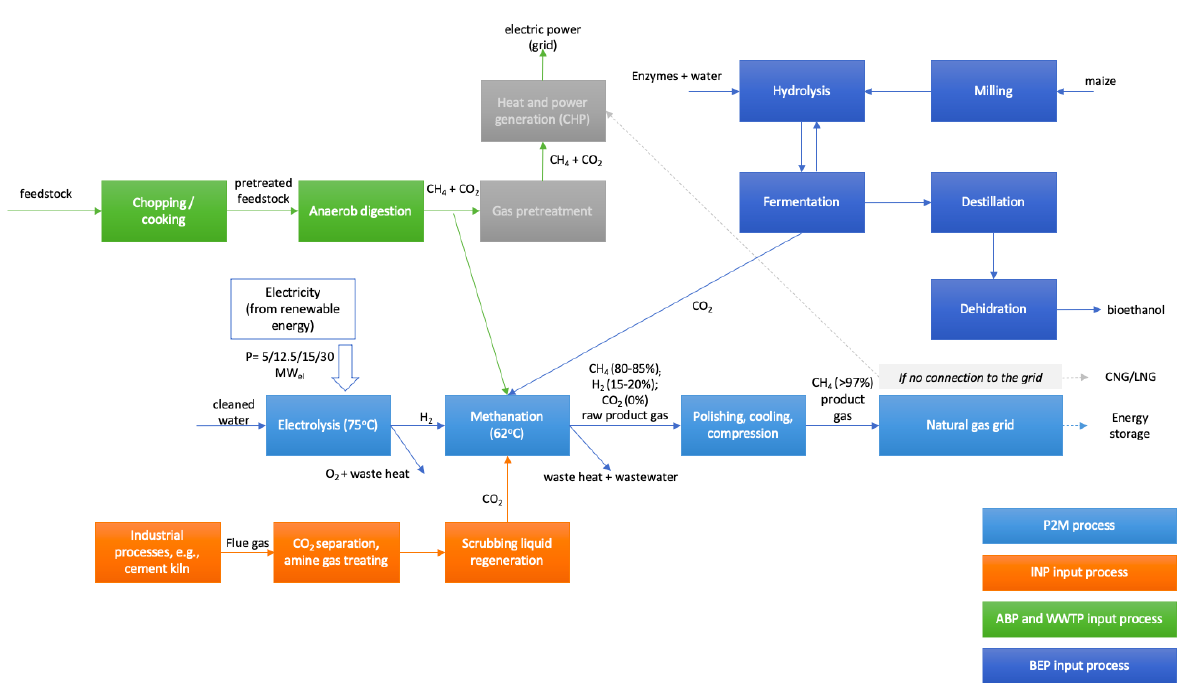
Figure 2. Simplified overview of the P2M process at an INP with carbon capture (orange), at a biogas plant of an agricultural company or a WWTP (green) or at a BEP (navy blue), based on Sin ó ros-Szab ó [63], Laude et al. [61], and Chauvy et al.